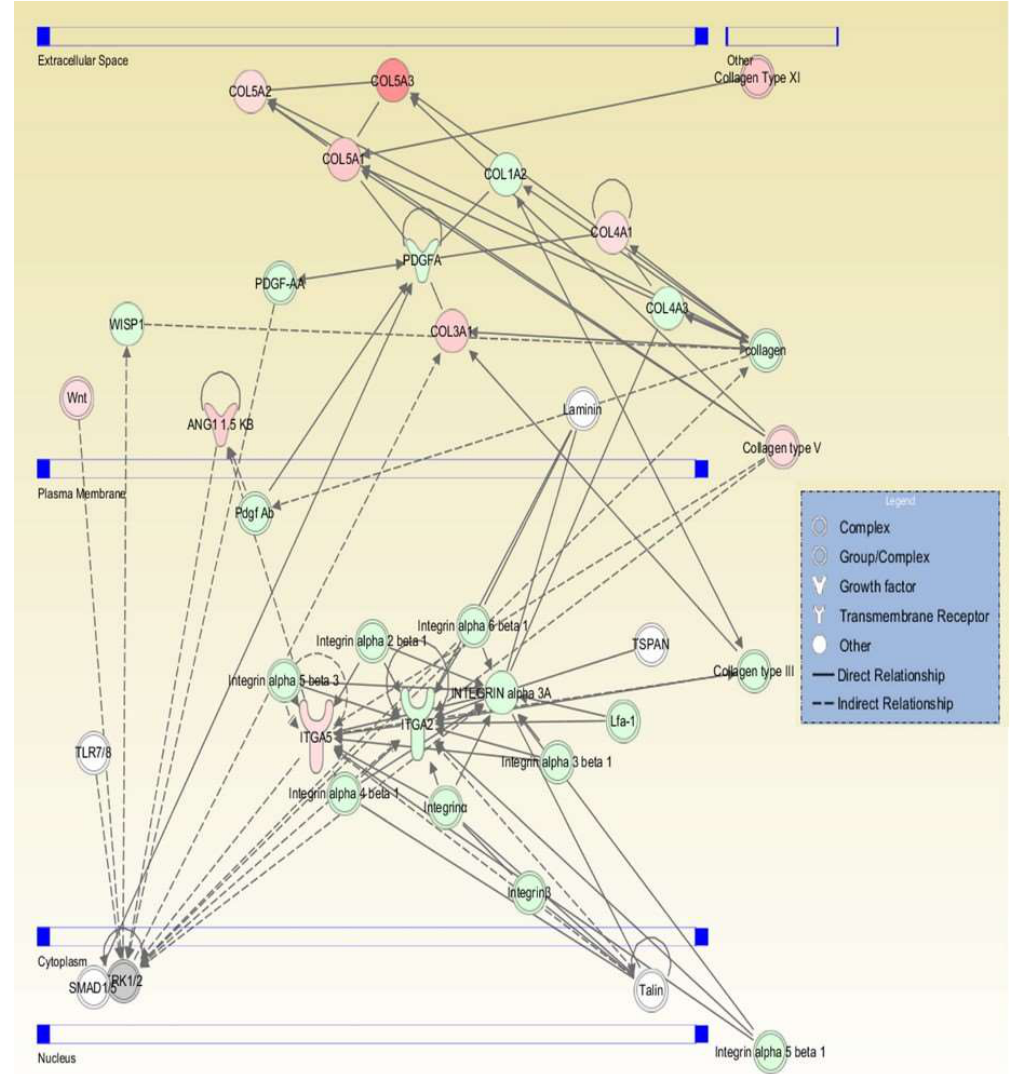
Figure 6. Graphic represents the interaction relationships for DFCM-KM2. The mutual genes in the target network are displayed as nodes, and include collagen (ECM), PDGF (growth factor) and integrin (cell adhesion molecules), which activate the ERK / MAPK pathway. Red nodes indicate upregulated genes; green nodes indicate downregulated genes.